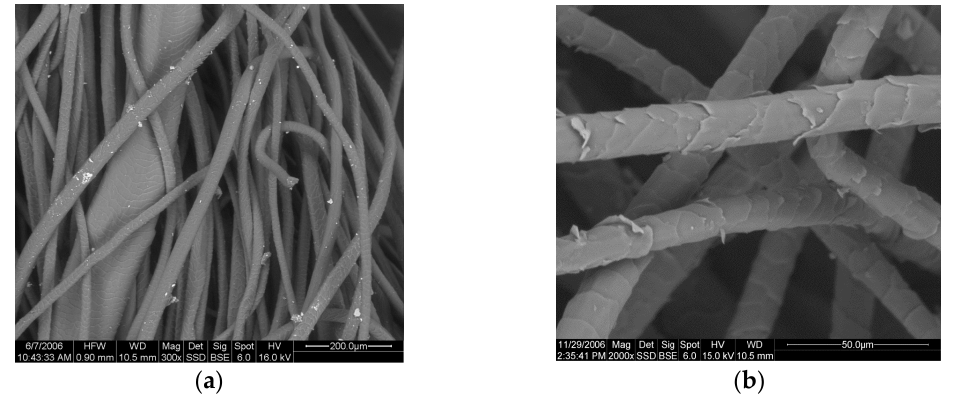
Figure 1. Electronic microscope details of sheep wool fibers. ( a ) 200 μ m rank; ( b ) 50 μ m